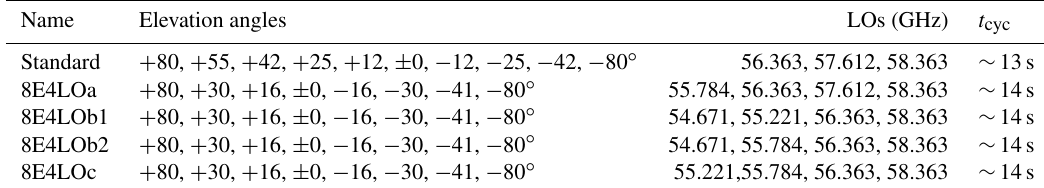
Table A2. Proposed measurement strategies for future missions of the HALO